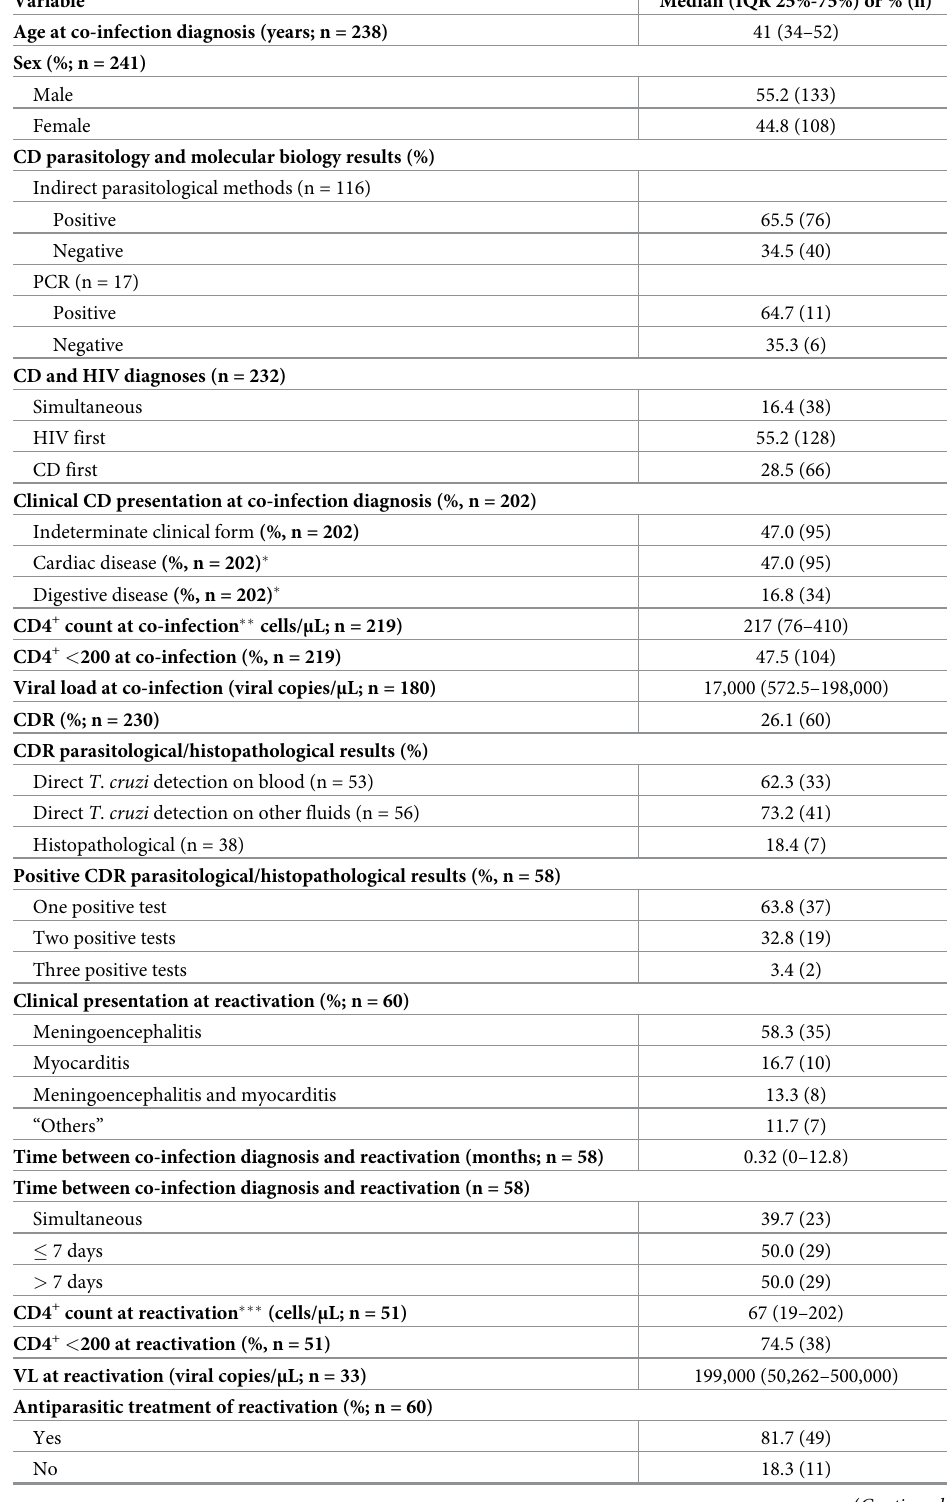
Table 1. Characteristics of T . cruzi/ HIV co-infected cases included in the study (n =